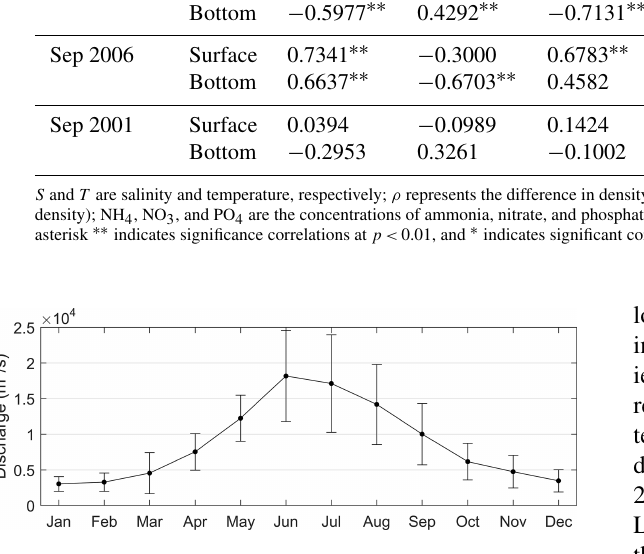
Figure 9. Monthly means and standard deviations of the Pearl River discharges calculated over